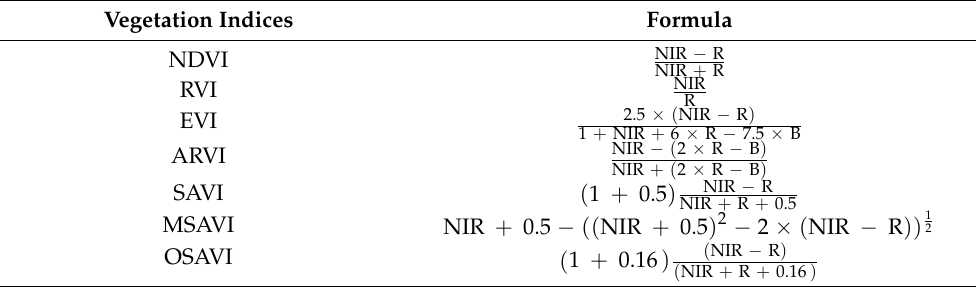
Table 3. Vegetation indices and their calculation